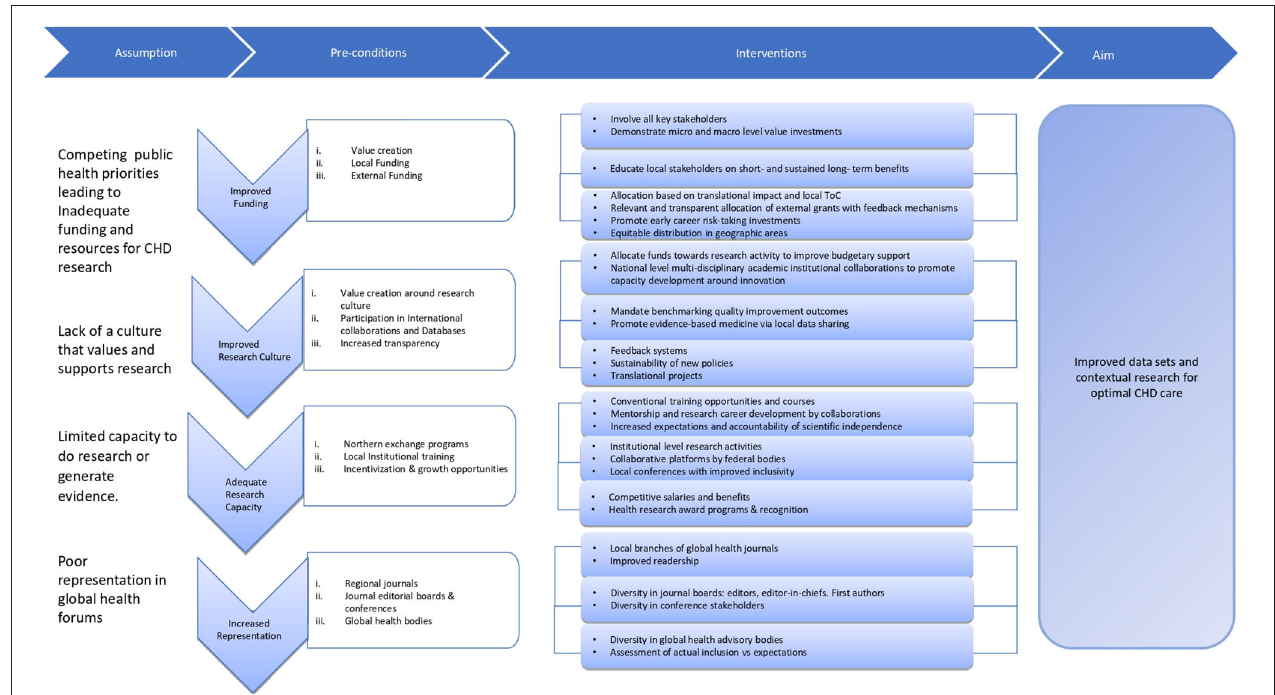
FIGURE 1 | Theory of change around increasing data generation and contextual research output in